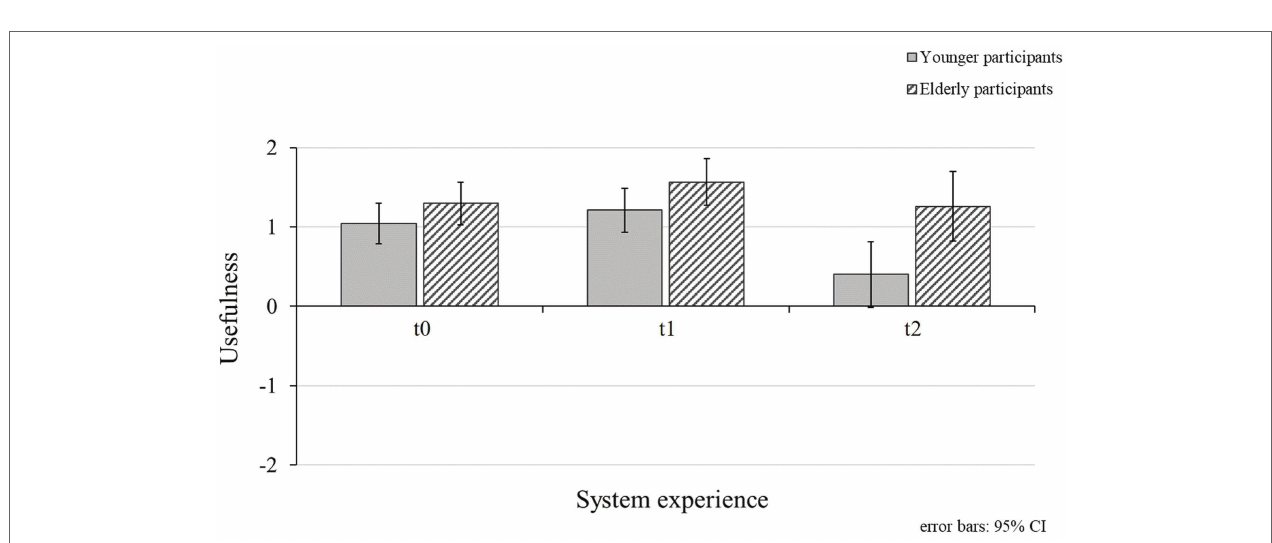
FIGURE 6 | Mean values for younger and elderly participants’ usefulness ratings for the different points of measurement (t0 = initial measurement; t1 = valid system functions; and t2 = valid and invalid system functions). Higher values represent higher usefulness ratings.